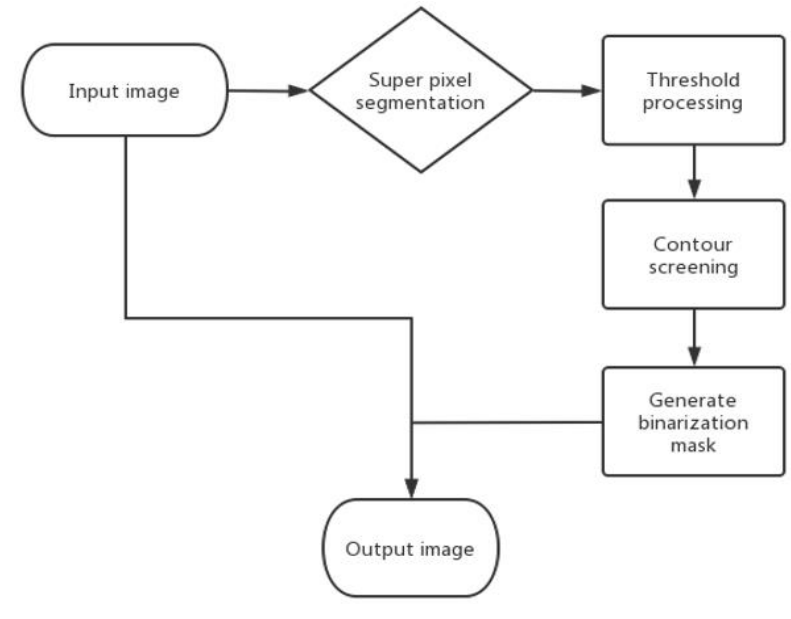
Figure 6. Land burial module.